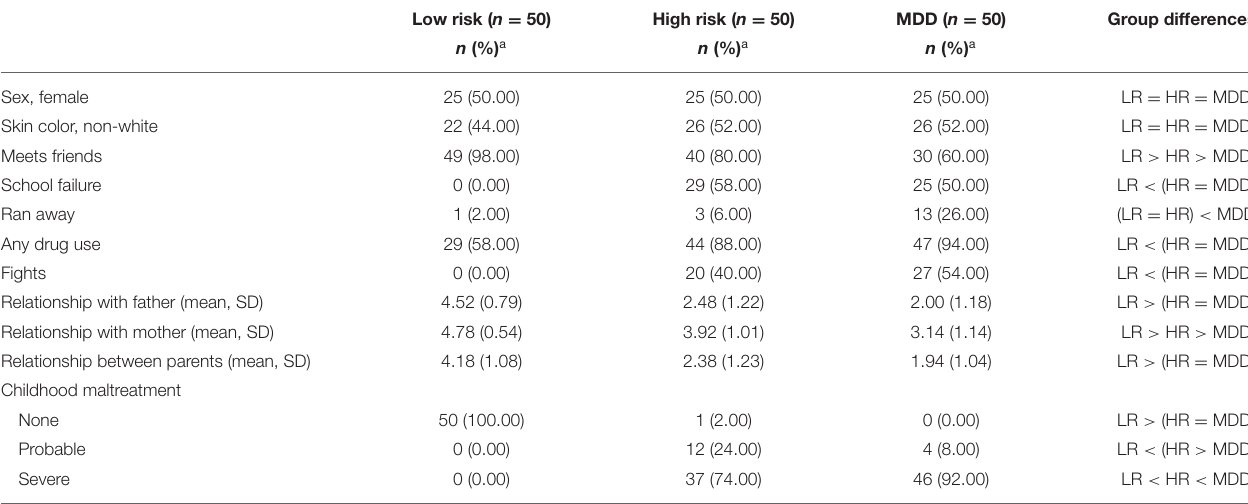
TABLE 3 | IDEA-RS features in the IDEA-RiSCo